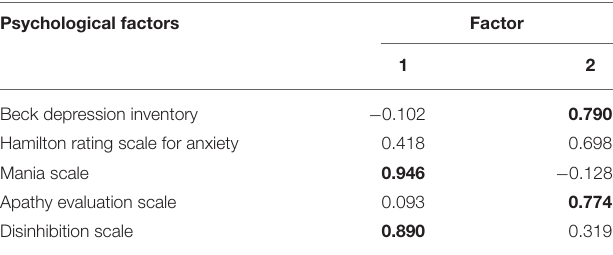
TABLE 3 | Pattern matrix for the principal components analysis—psychological factors (T0). Psychological